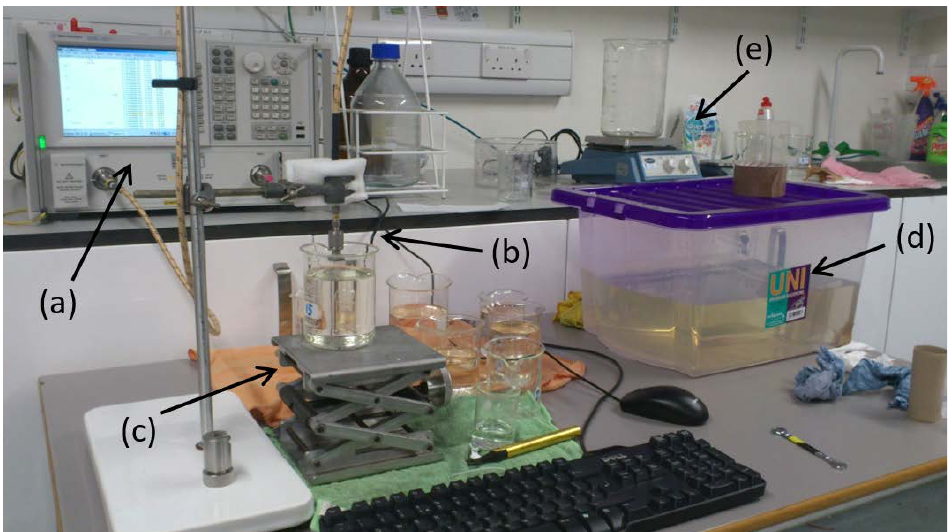
Figure 2. Setup for measuring the dielectric properties of liquid phantoms. ( a ) PNA. ( b ) Dielectric probe. ( c ) Platform to move the sample. ( d ) Tank to store the phantom. ( e ) Heater and mixer to fabricate the